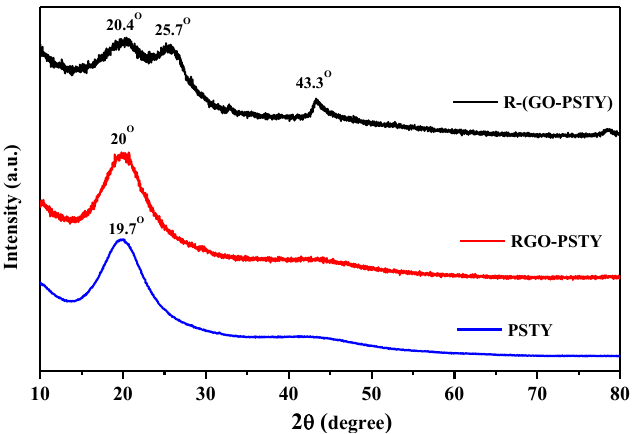
Figure 3. XRD patterns of a neat PSTY, RGO-PSTY and R-(GO-PSTY)